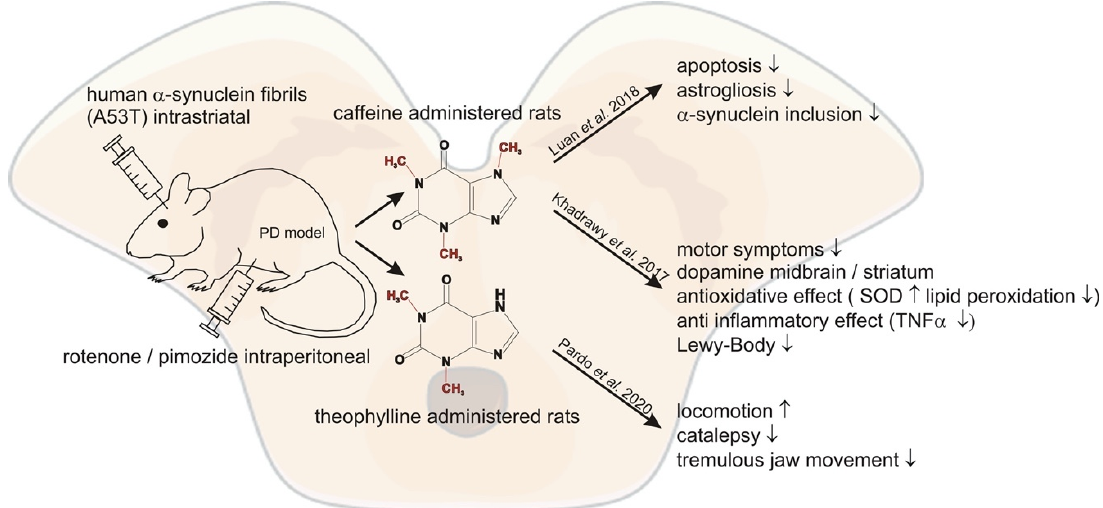
Figure 2. Summary of the molecular mechanisms reported in recent literature potentially mediating the beneficial effects of methylxanthines in respect to Parkinson´s disease.